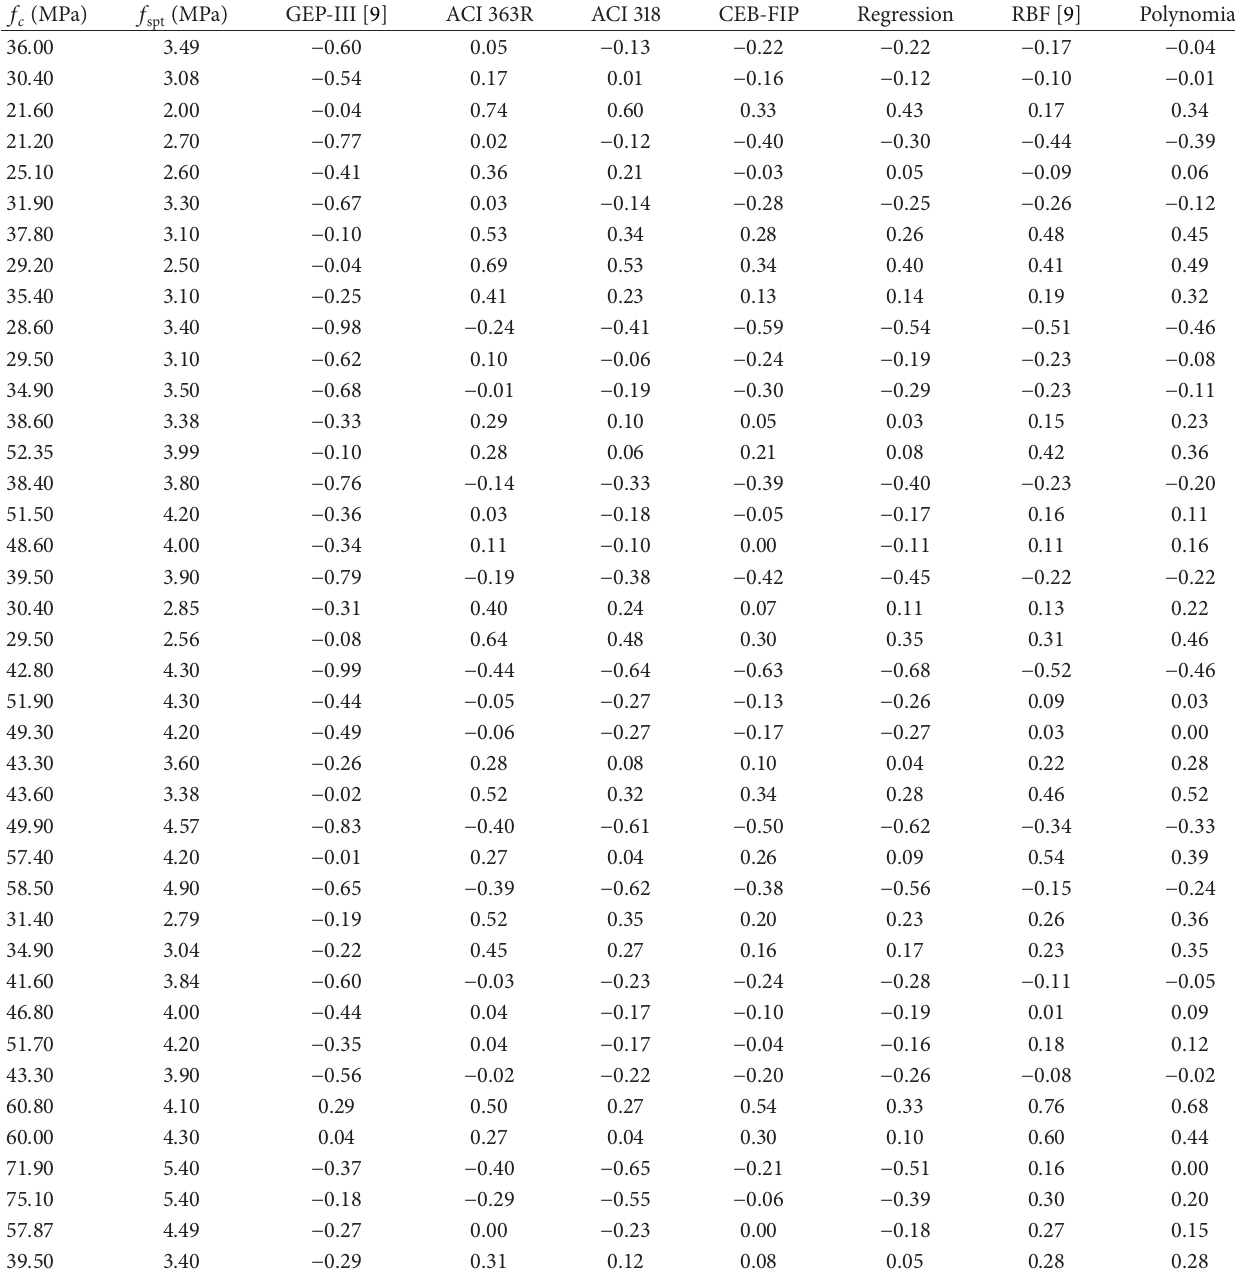
Table 5: Comparison of experimental results to testing results of RBF, polynomial of SVM-II, and other models. 𝑓 𝑐 (MPa)